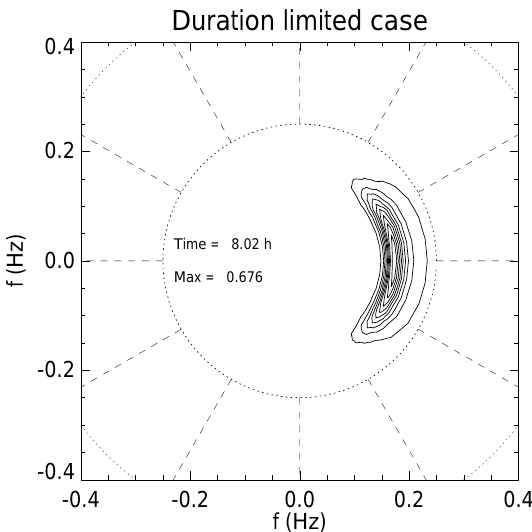
Figure 10. Angular spectrum for the wind speed U = 10ms − 1 du- ration limited case.